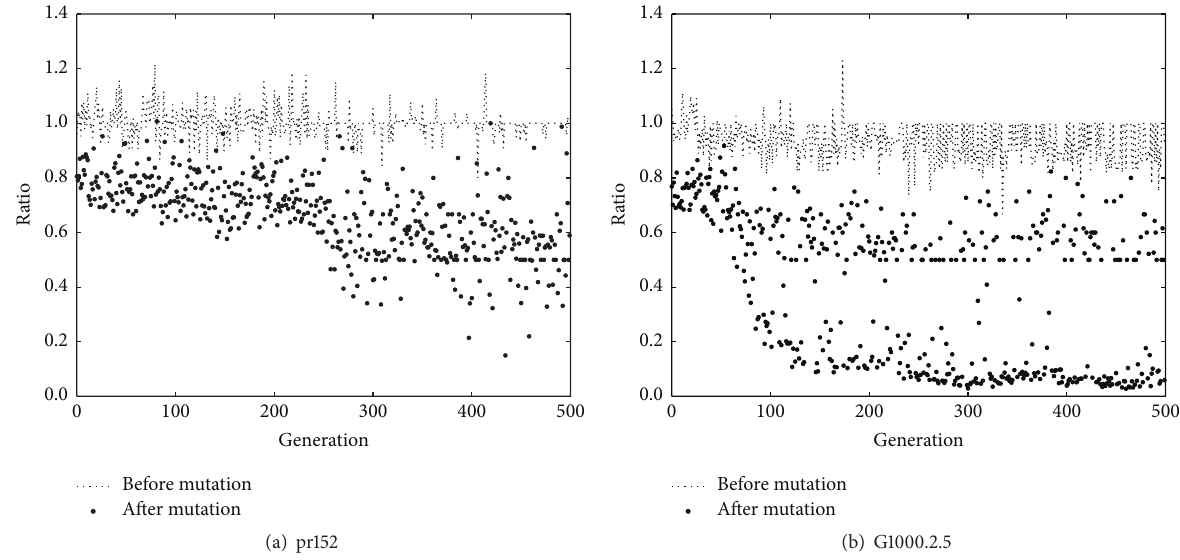
Figure 2: Median of ratio values according to